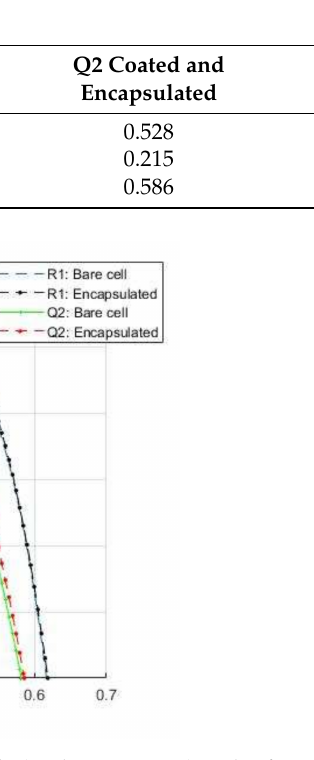
Figure 5. I-V characteristic of coated Q2 sample (with PA Si-QDs) and reference R1 sample before (bare cell) and after